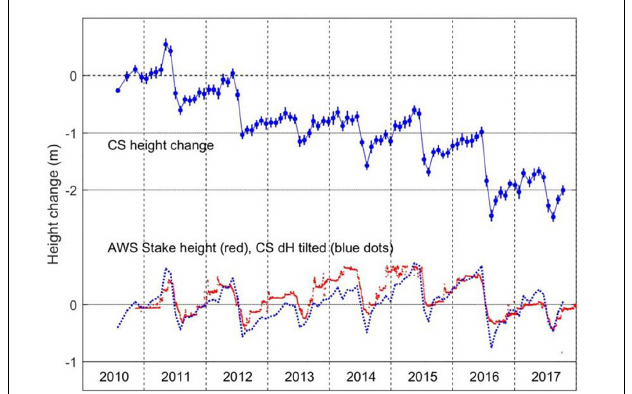
FIGURE 11 | Illustration of the correlation between the temporal height change from the CryoSat data (upper blue plot) and the relative height change from the stake mounted sonic ranger sensor on the KPCU AWS (lower red plot). The blue dotted plot superimposed on the red AWS stake height plot is the height change corrected for an assumed constant downward motion of the